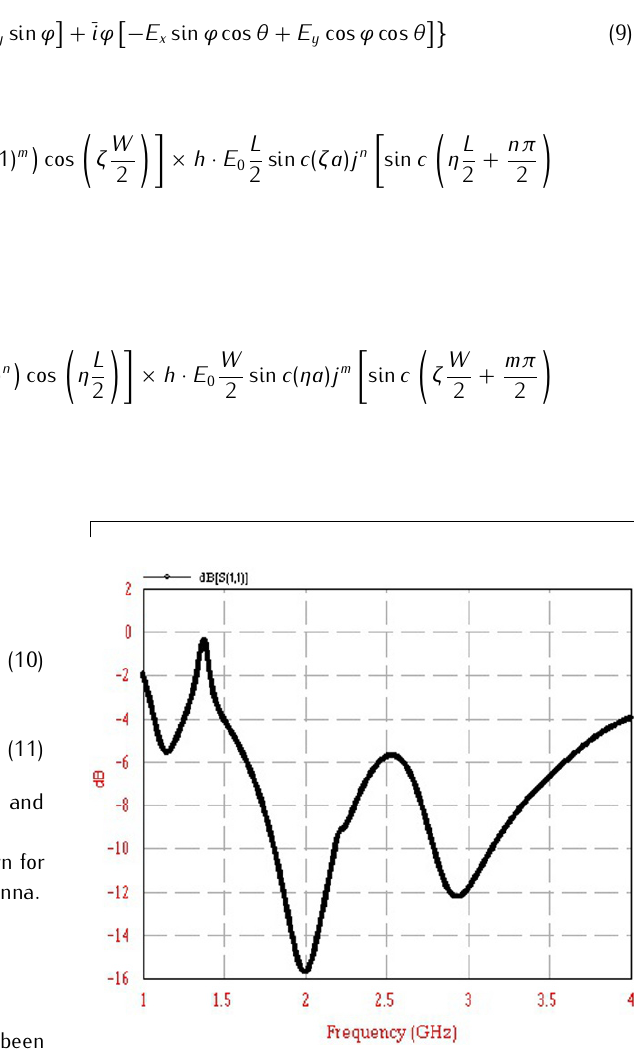
Figure 2. Return loss Vs frequency plot of slotted microstrip antenna.